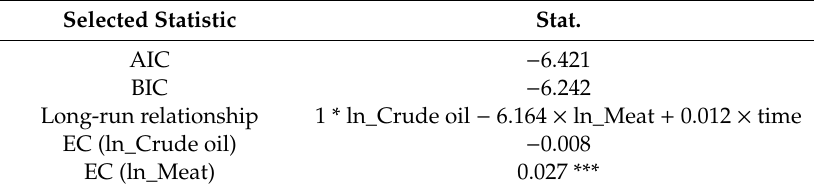
Table A2. Selected VECMs